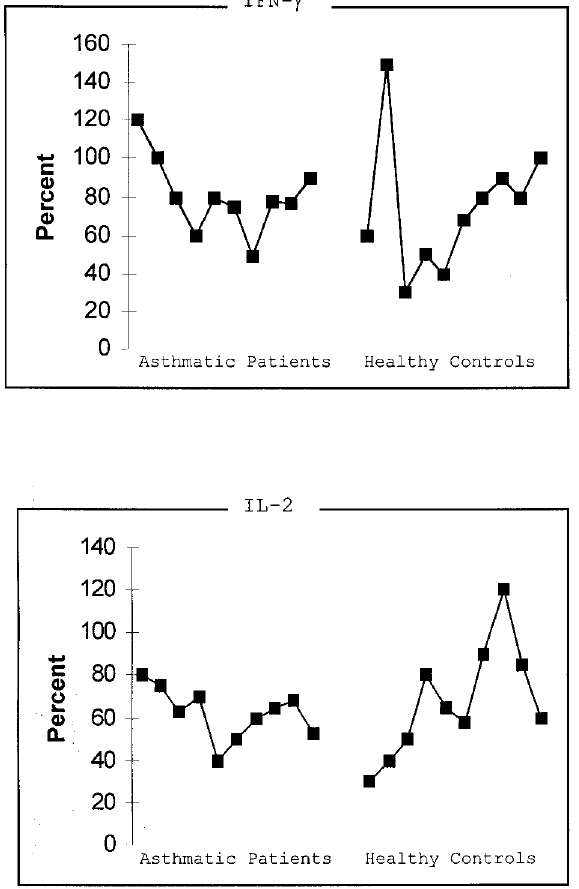
FIG. 2. Individual expression of mRNA for IFN– g and IL–2 in asthmatic patients and healthy controls in sputum mono- nuclear cells. The expression of mRNA is shown as percen- tages relative to the signals of b -actin.